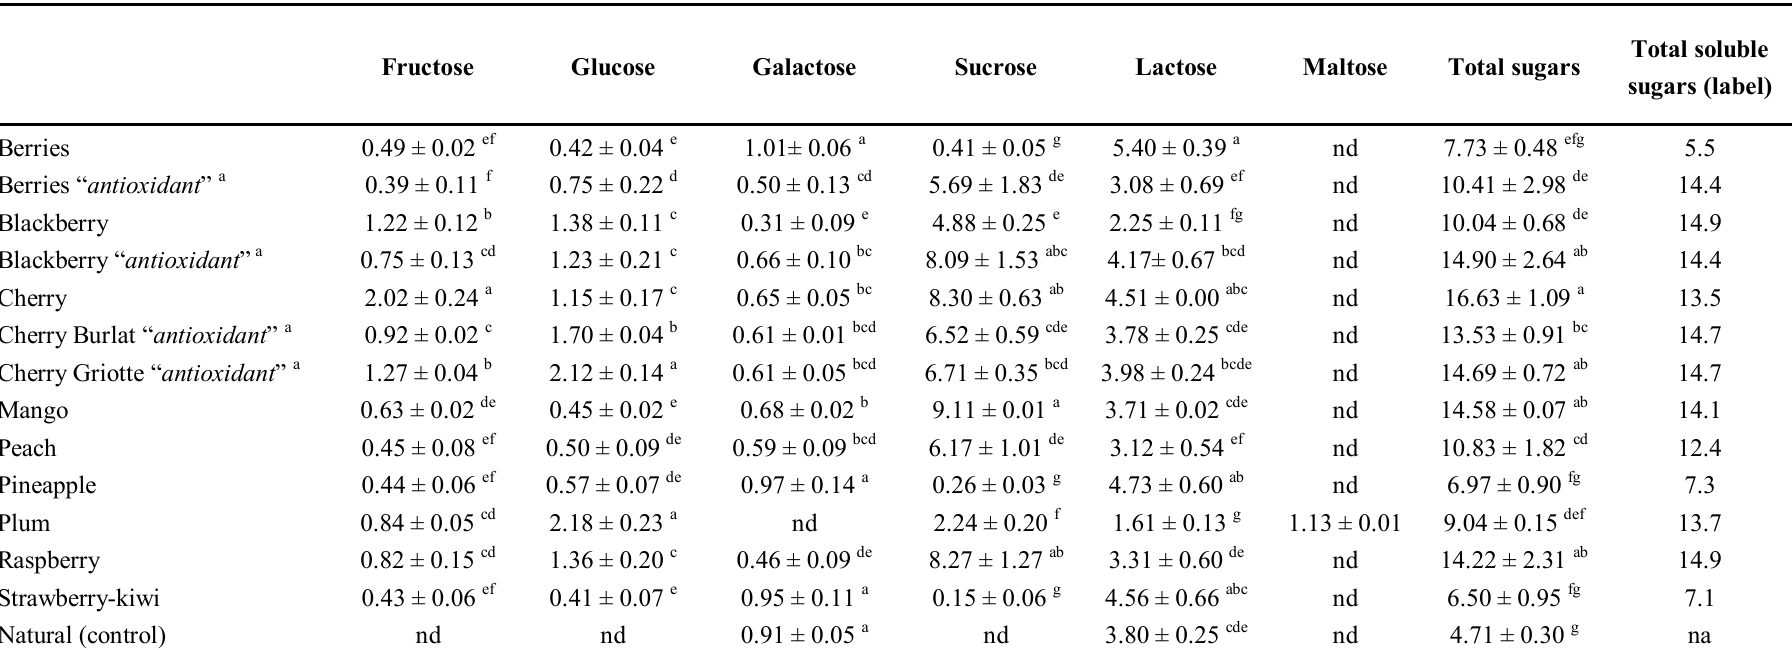
Table 3. Sugars composition of the studied yogurts obtained by chromatographic analysis (mean ± SD) and comparison with the information about total sugars available in the